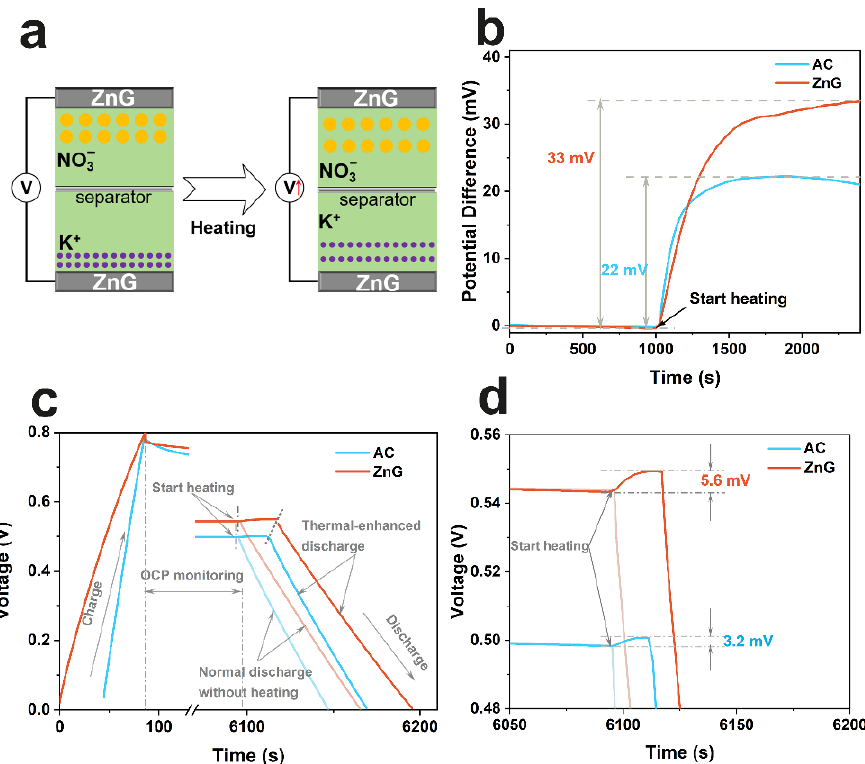
Figure 5. Comparison of thermal conversion ability between ZnG and AC. Schematic illustration of thermal charging mechanism, where the thermally induced electric double layer expansion increases the voltage ( a ); Seebeck coefficient tested at H-type electrochemical cell ( b ); charging–stabilizing–heating–discharging tests at 0.5 A · g − 1 ( c ); the amplification of the heating–discharging part ( d ).